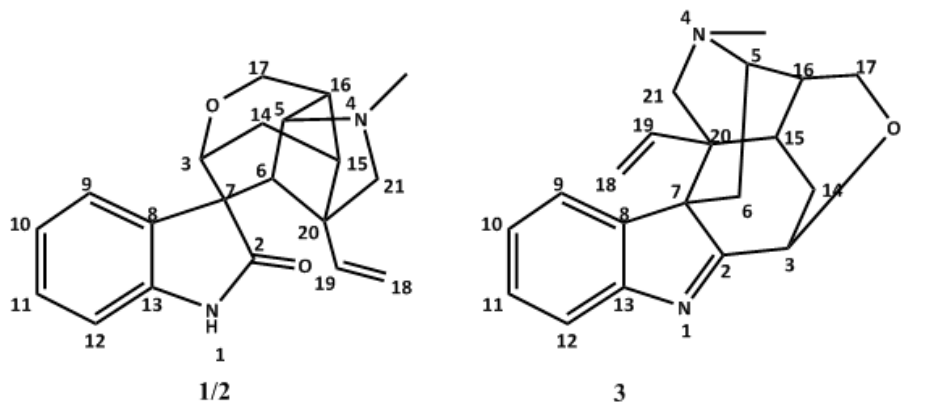
Figure 1. The structures of compound (±)-gelsemine ( 1 / 2 ) and koumine ( 3 ).